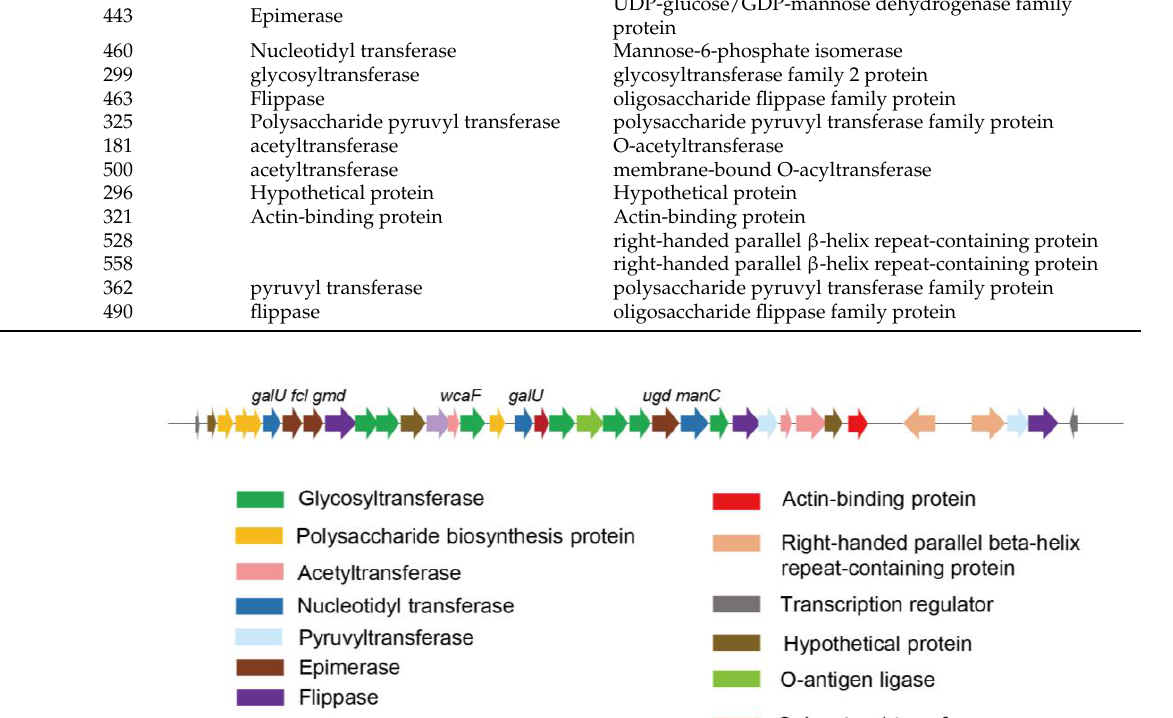
Table 7. Putative biofilm formation-related genes in P. mucilaginosus G78. KEGG Orthology